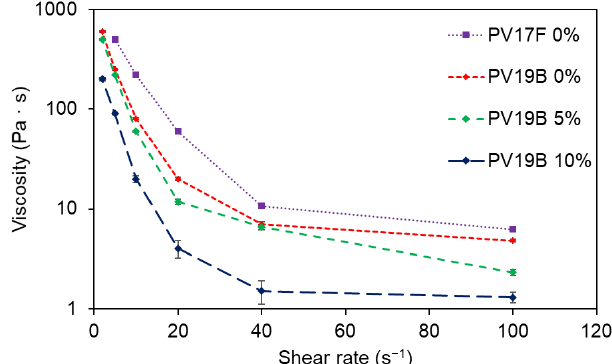
Figure 2. Viscosity against shear rate for DuPont ® PV17F and PV19B silver pastes considering different added solvent concentration mixtures: raw PV17F paste [14] (purple squares, dotted line), raw PV19B paste (red diamonds, short-dashed line), PV19B paste with 5 wt. % solvent concentration (green diamonds, medium-dashed line), and PV19B paste with 10 wt. % solvent concentration (navy diamonds, long-dashed line).